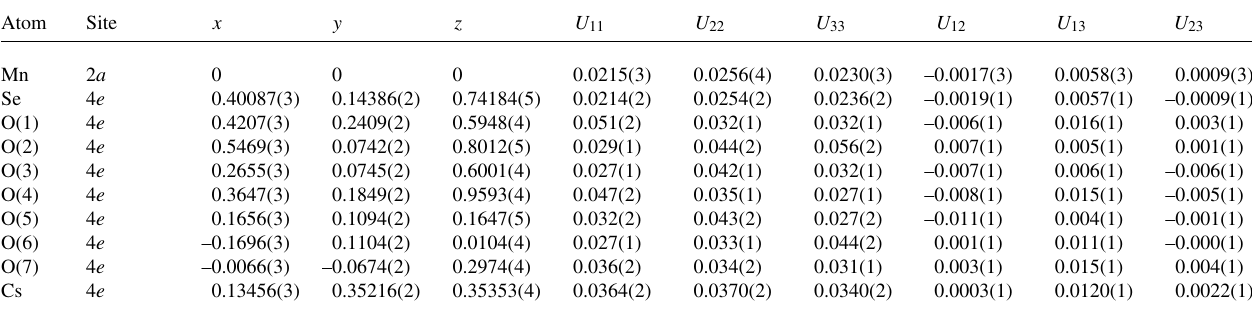
Table 6. Atomic coordinates and displacement parameters (in Å 2 )